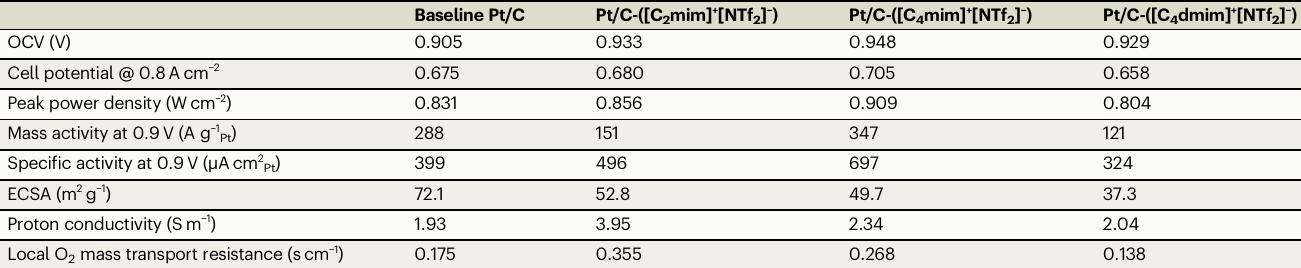
Table 2 | Electrochemical properties of baseline Pt/C MEA obtained after two voltage recovery cycles and Pt/C-IL MEAs obtained after three voltage recovery cycles in fuel cell set-up